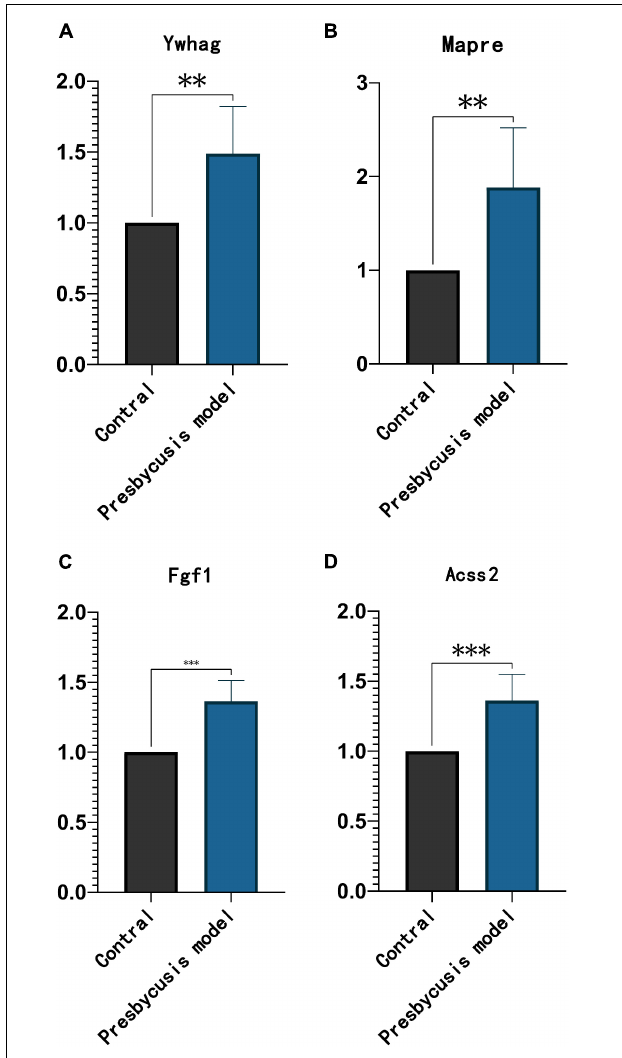
FIGURE 9 | The expression trend of prognostic factors in the inner ear of D-galactose induced rats. The expression of Ywhag (A) , Mapre2 (B) , Fgf1 (C) , and Acss2 (D) . ∗∗ p < 0.01 and ∗∗∗ p < 0.001 compared with